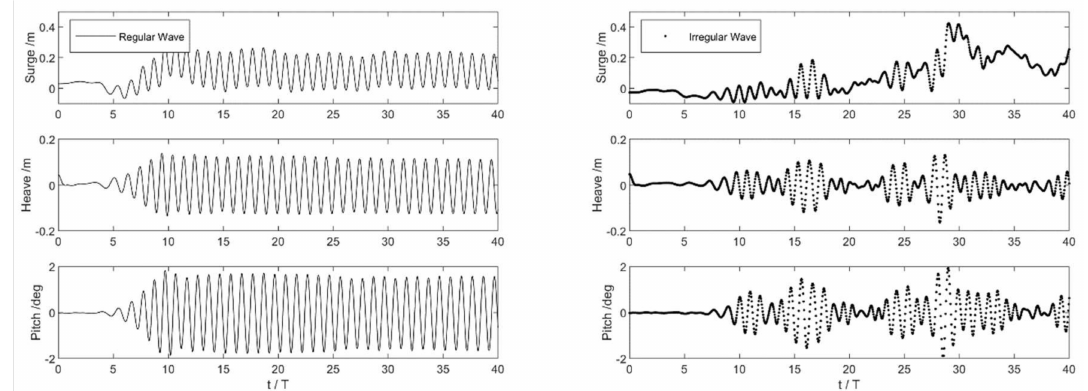
Figure 13. Time series of 3-DoF motions of the mariculture platform under the regular and irregular waves with H = 0.6 m and T = 5 s simulated with